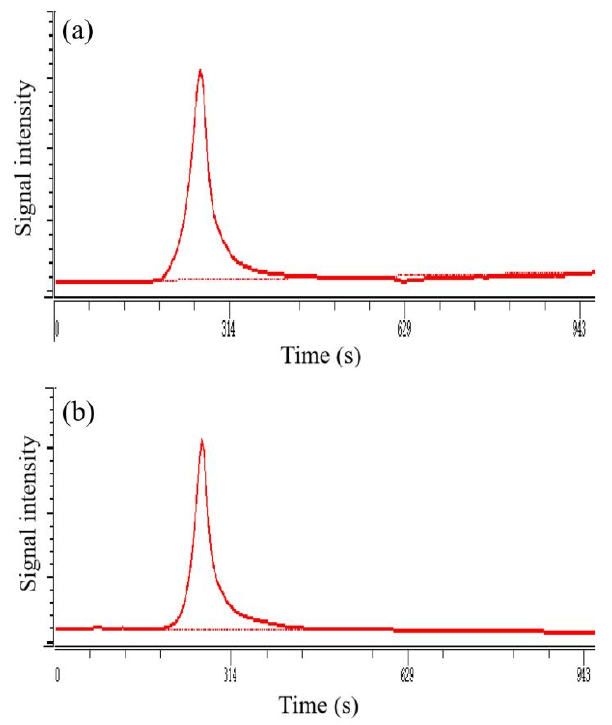
Figure 5. High performance gel permeation chromatography of AcRDP-1 ( a ) and AcRDP-2 ( b ).